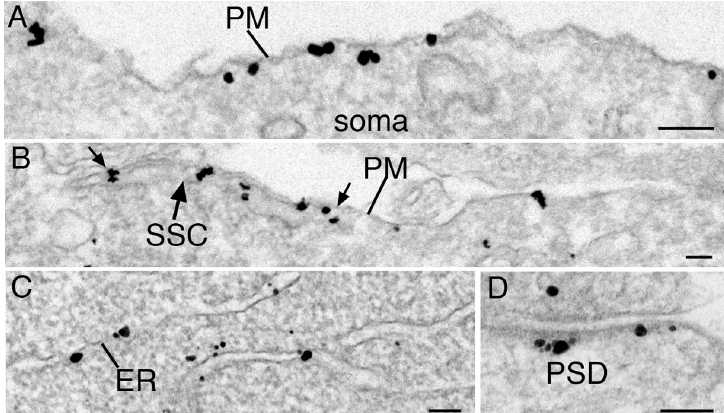
Fig 3. Densin immunolabel on extrasynaptic membranes. Electron micrographs showing immunogold labeling of cultured hippocampal neurons using densin antibody 2. Labeling on plasma membranes (PM, A, B) and ER (C) as well as on PSDs (D) is detected. Subsurface cisterns (SSC) were occasionally observed under patches of plasma membrane with a cluster of densin label (area bordered by the two small arrows). Scale bar = 0.1 μ m.